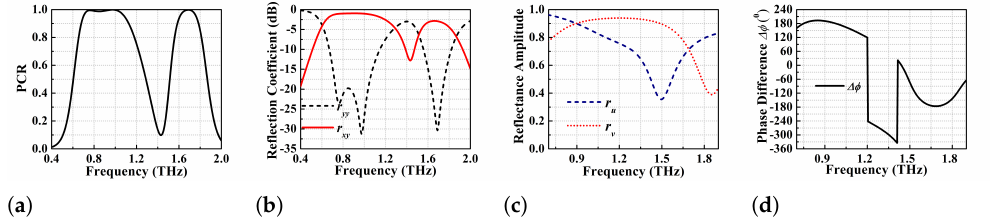
Figure 12. Proposed dual-band polarisation conversion performance analysis ( a ) PCR ( b ) r yy and r xy ( c ) r u and r v ( d ) phase difference between r u and r v .